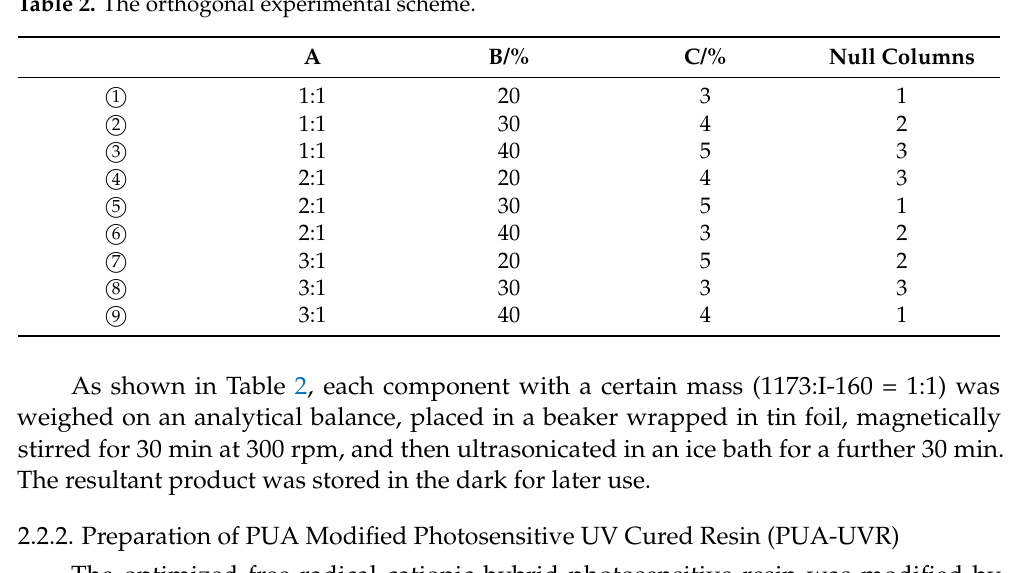
Table 2. The orthogonal experimental